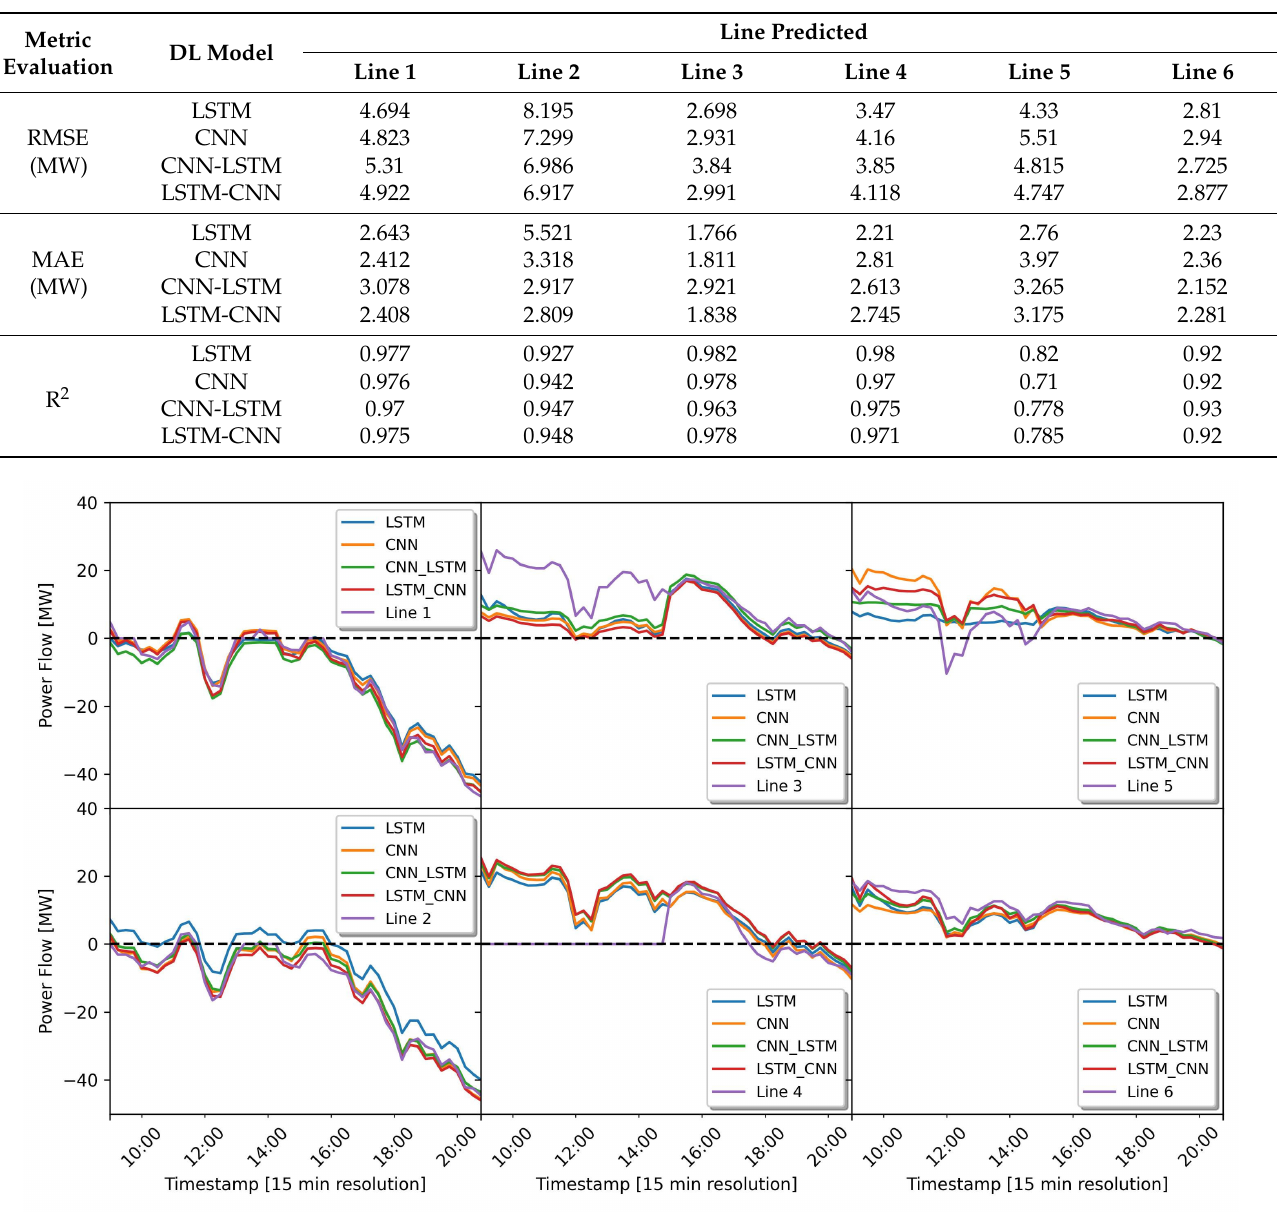
Table 7. Performance evaluation of the deep learning models based on power flow data.